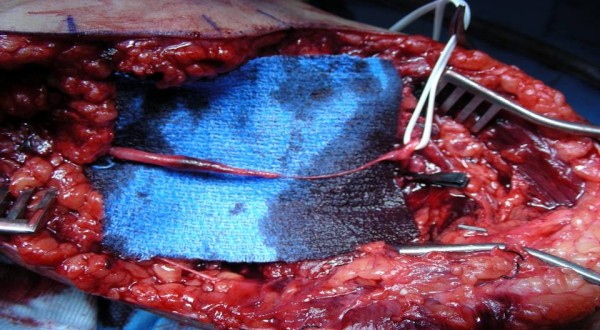
Same case as in figures 3, 4, 5. The intraoperative finding correlates to preoperative CT-angiography, revealing a brachial artery traction injury of about 5 cm length, located proximal to the bifurcation.